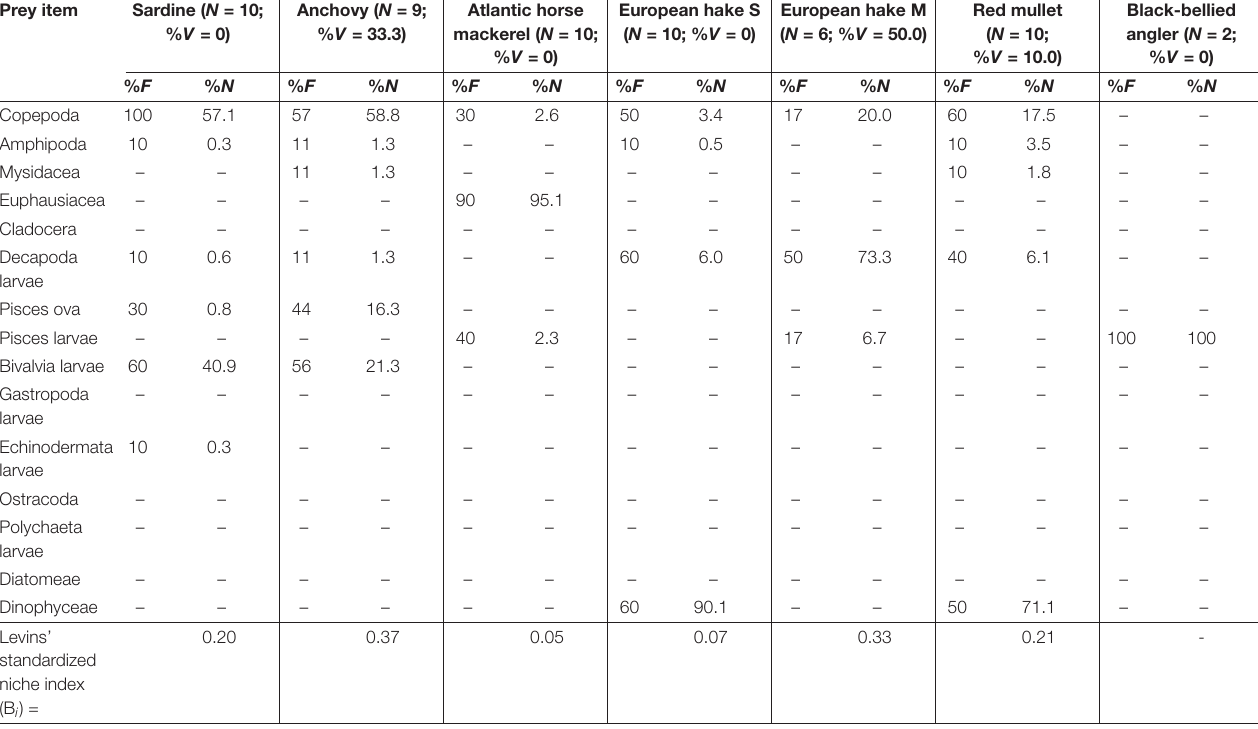
TABLE 3 | Frequency of occurrence (% F ) and abundance (% N ) of prey items found in the sardine, anchovy, Atlantic horse mackerel, European hake [by size classes: small (S: TL < 20.0 cm), medium (M: 20.1 cm < TL < 30.0 cm) and large (L: 30.1 cm > TL)] and red mullet collected in the Southern area of eastern Adriatic Sea during MEDITS survey (June–July, 2018) along with number of analyzed specimens ( N ), its vacuity index (% V ) and Levins’ standardized index (B i ). Prey